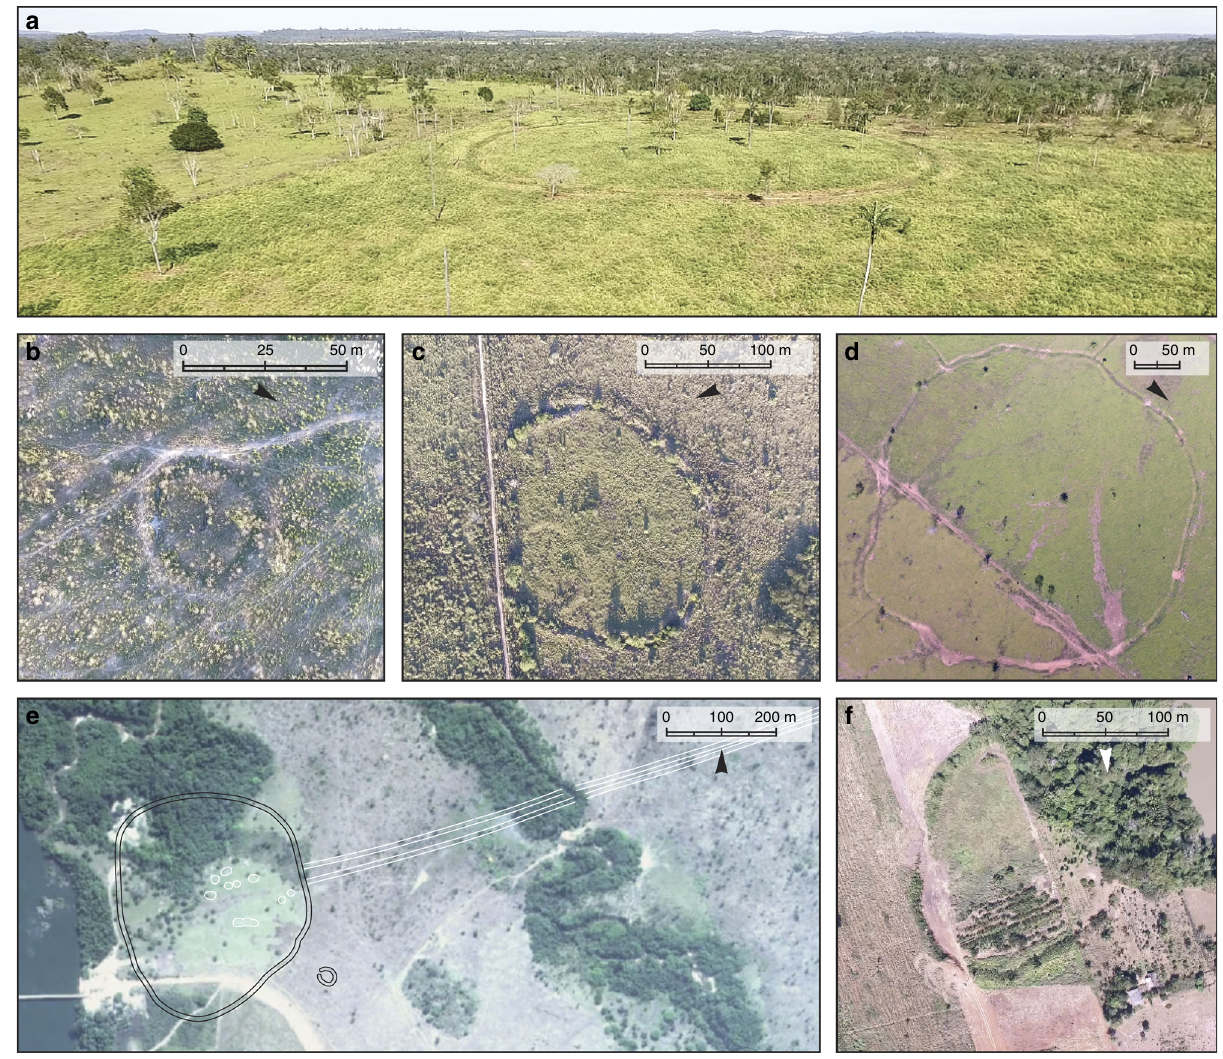
Fig. 3 Ditched enclosures of the UTB. a Typical position of ditched enclosures in the landscape, on plateaus overlooking rivers (site Mt-05); b Example of a small enclosure (site Z-Mt-29). Scale bar = 50m; c Compound structure with a small enclosure in the interior of a larger one (site Z-Mt-05). Scale bar = 100 m; d Part of the site Z-Mt-04, showing the wavy pattern of ditch construction. Scale bar = 50m; e Plan of a major regional centre, site Mt-07, with ditches outlined in black and mounds/walls outlined in white (Satellite image ©2018 Google, DigitalGlobe). Scale bar = 200m; f Site Mt-04. Scale bar =